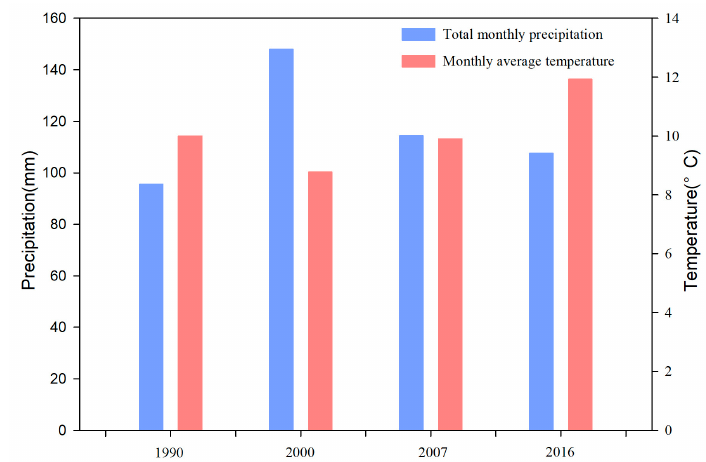
Figure 8. Total monthly precipitation and monthly average temperature in the study area in 1990, 2000, 2007 and 2016.